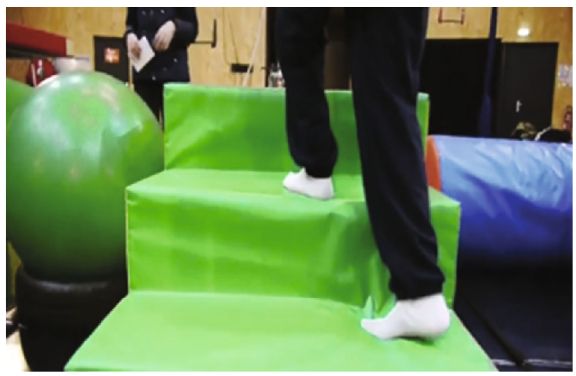
Figure 4: Participant climbing stairs as part of a circus obstacle course [36].